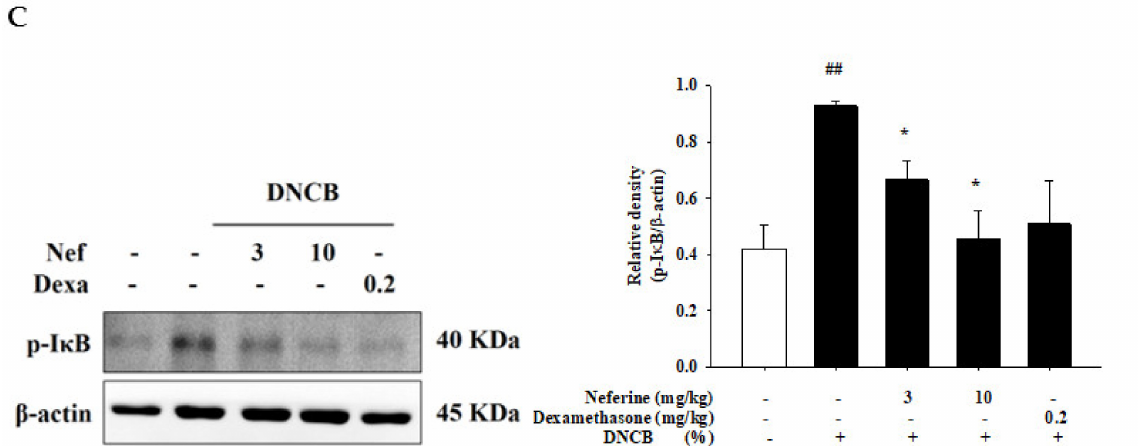
Figure 9. Effect of neferine on p38 ( A ), ERK ( B ), and I κ B ( C ) activation in BALB/c mice with an atopic-dermatitis-like phenotype. Western blots were analyzed quantitatively. Values represent the mean ± SEM from at least six independent experiments. ## p < 0.01 compared with the no-treatment condition; * p < 0.05 and ** p < 0.01 compared with the DNCB- induced group.